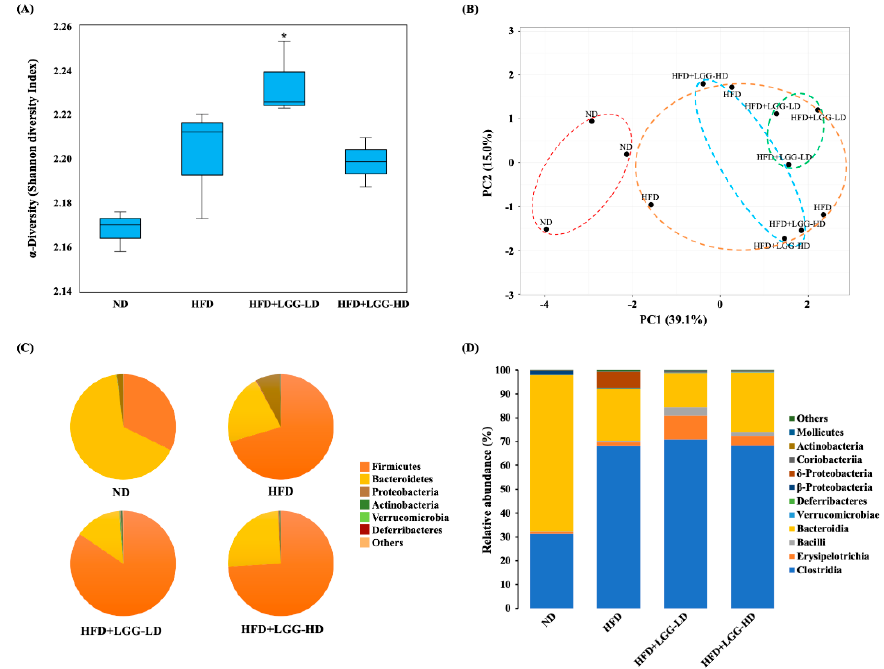
Figure 5. Effect of administration of Lactobacillus rhamnosus GG (LGG) on the fecal microbiota of mice with diet-induced obesity. ( A ) Boxplot representation of Shannon diversity index. Bar marked with a star * means that it is significantly different from the ND group at p < 0.05. ( B ) Two-dimensional plot of principal component analysis. ( C ) Fecal microbial composition at phylum level. ( D ) Fecal microbial composition at class level. ND: normal diet; HFD: high-fat diet; HFD+LGG-LD: high-fat diet supplemented with low-dose LGG (10 8 CFU/mouse/day); HFD+LGG-HD: high-fat diet supplemented with high-dose LGG (10 10 CFU/mouse/day).